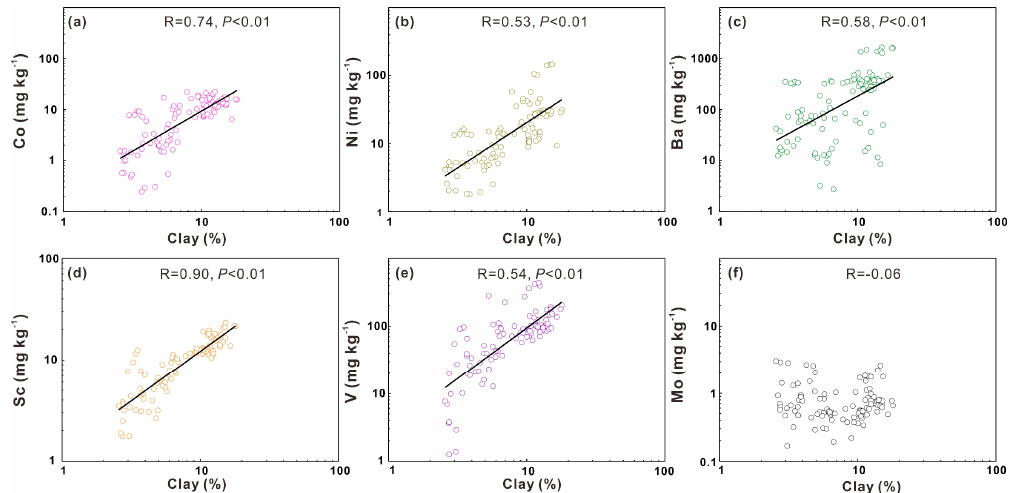
Figure 7. Linear correlation between clay contents and the heavy metals Co ( a ), Ni ( b ), Ba ( c ), Sc ( d ), V( e ), Mo ( f ).